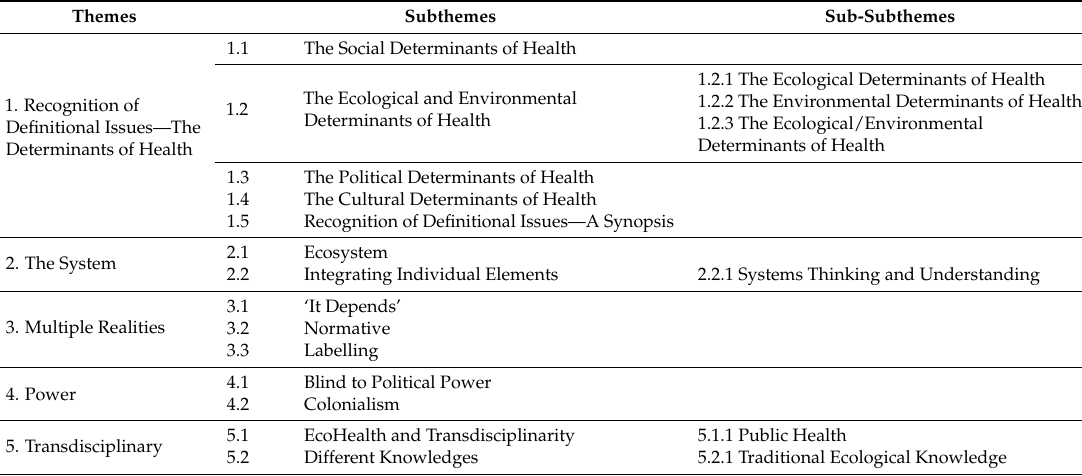
Table 2. Overview of the Themes and Subthemes that emerged from the views of Canadian EcoHealth Community